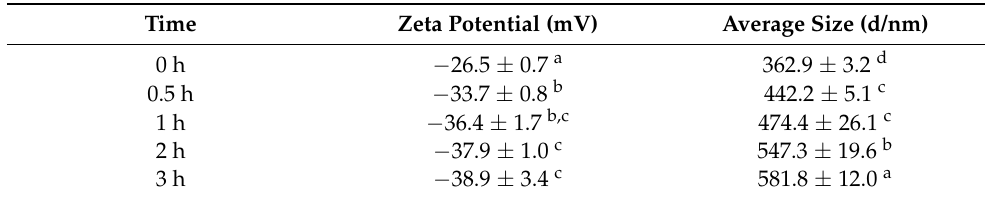
Table 1. Zeta potential and particle average size of soymilk samples incubated with TGase at 50 ◦ C for different time